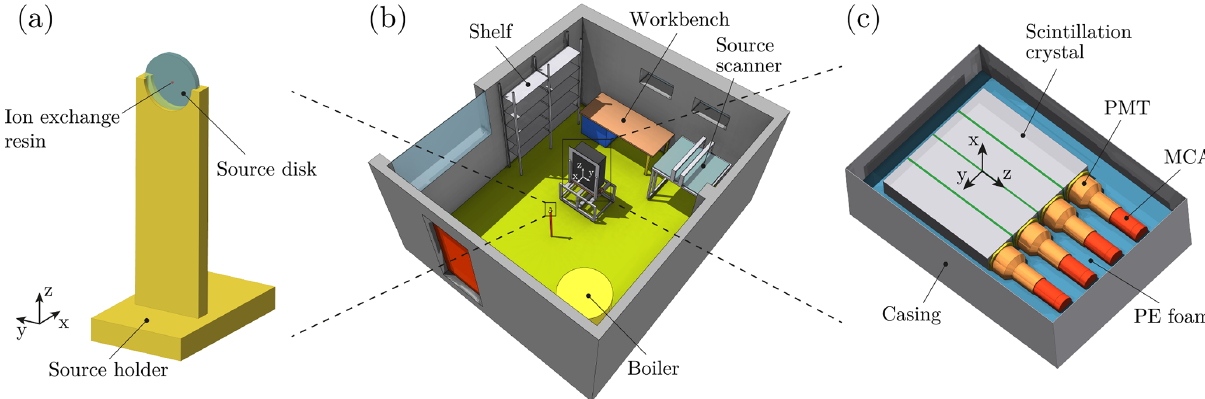
Figure 1. Experimental setup in the calibration laboratory at the Paul Scherrer Institute (PSI). (a) Radiation source including the source holder, the radiation source disk (25mm × 3mm) and the ion exchange resin sphere (1mm), in which the activity mass is embedded. (b) Cut view of the laboratory room (5.3m × 4.5m × 3m) with the detector mounted on an aluminum frame and the source on a tripod. (c) Cut view of the detector box (86cm × 60cm × 30cm) including the internals such as the scintillation crystals, photomultiplier tubes (PMT), multi-channel analyzers (MCA) and polyethylene (PE) foam. All figures were created using the graphical interface FLAIR (Vlachoudis, 2009). For better visibility and interpretability, false colors are